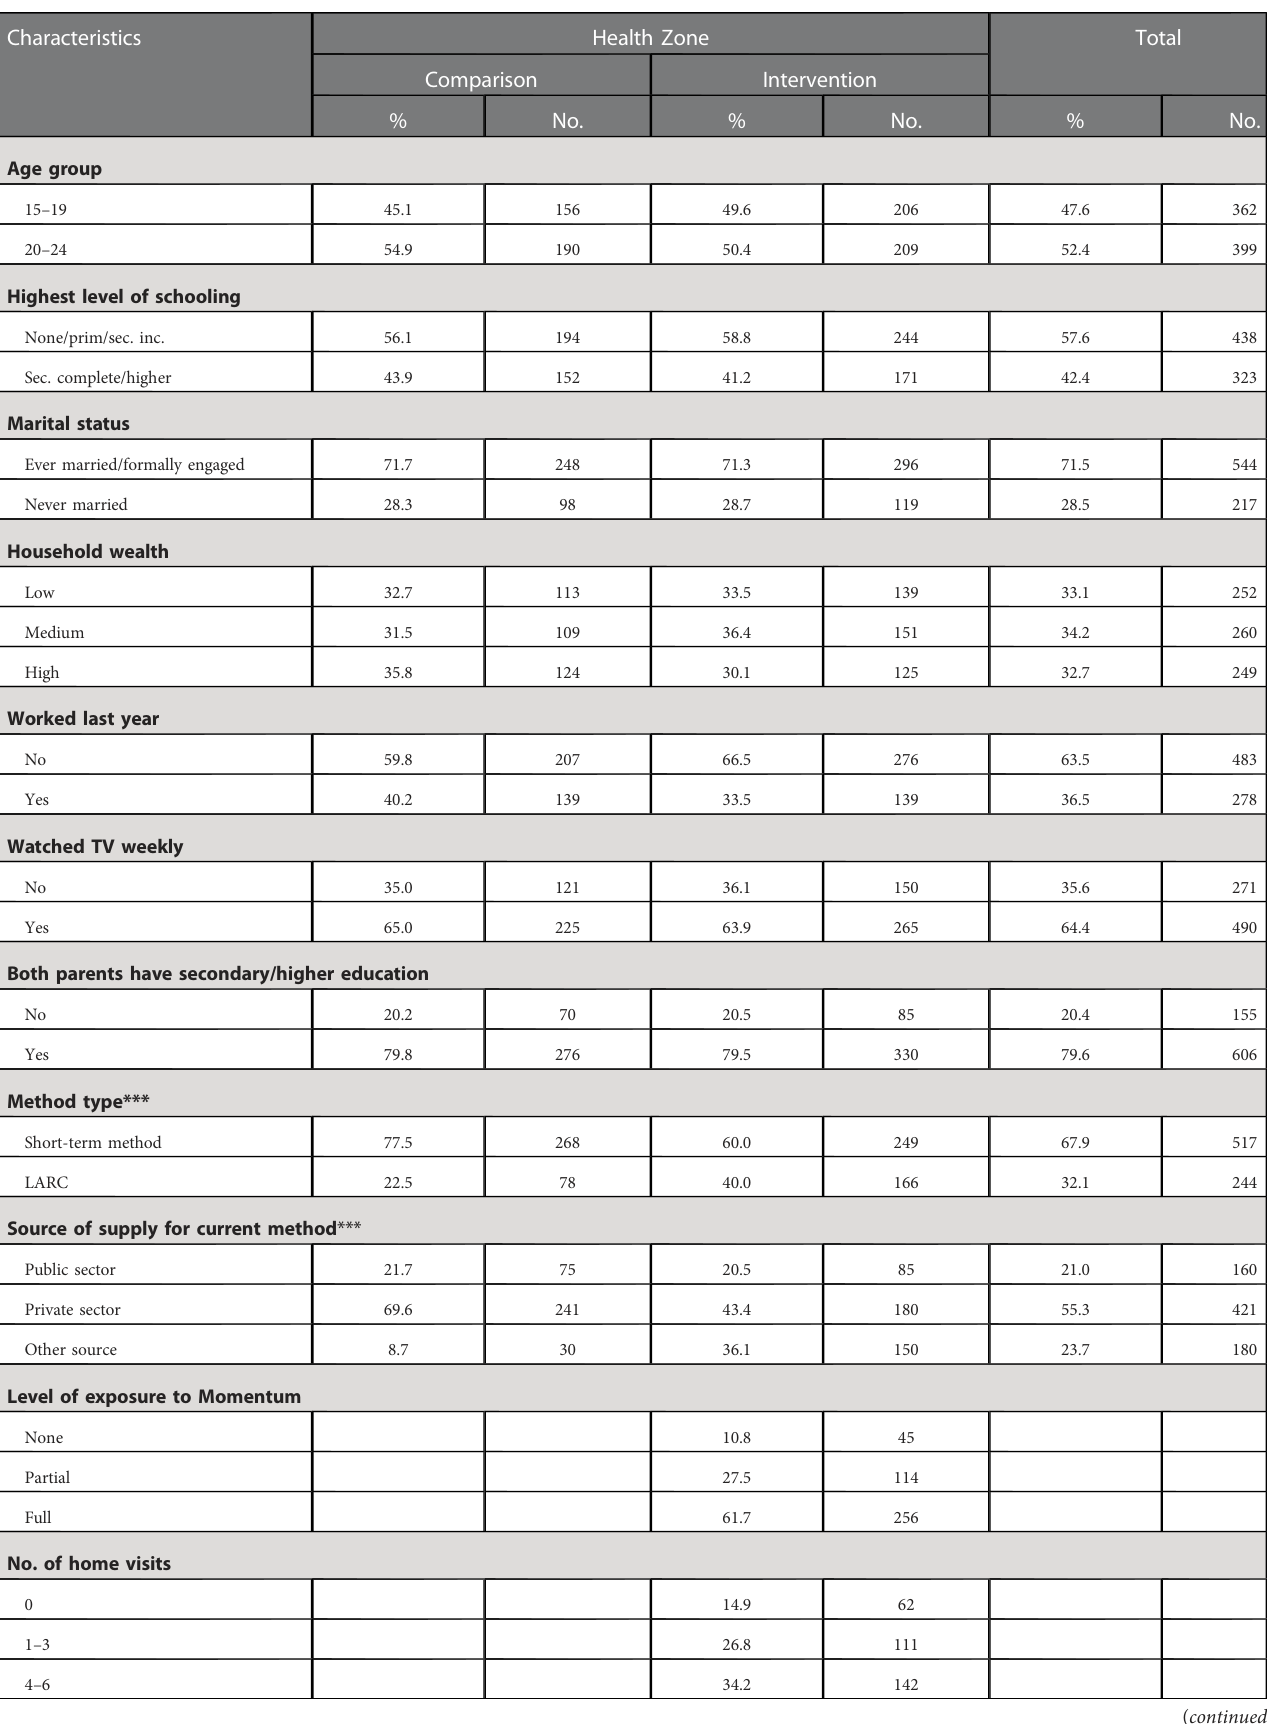
TABLE 1 Percent distribution of fi rst-time mothers age 15 – 24 who were currently using a modern method of contraception by baseline characteristics and health zone, Kinshasa.